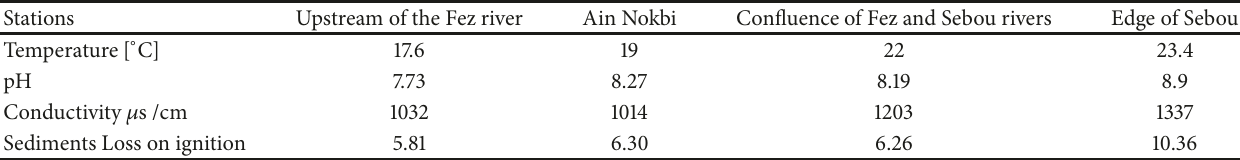
Table 2: The physiochemical parameters and the percentage of organic matter of